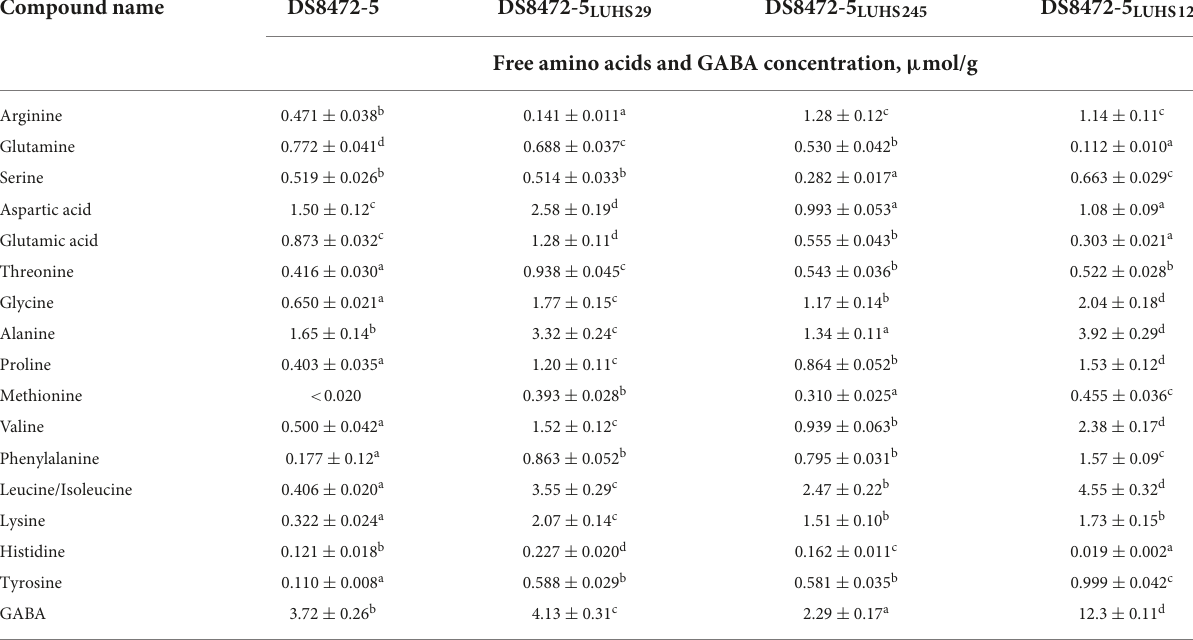
TABLE 1 Free amino acids (FAA) and gamma-aminobutyric acid (GABA) content in wheat cereal wholemeal (WCW) (DS8472-5) samples.